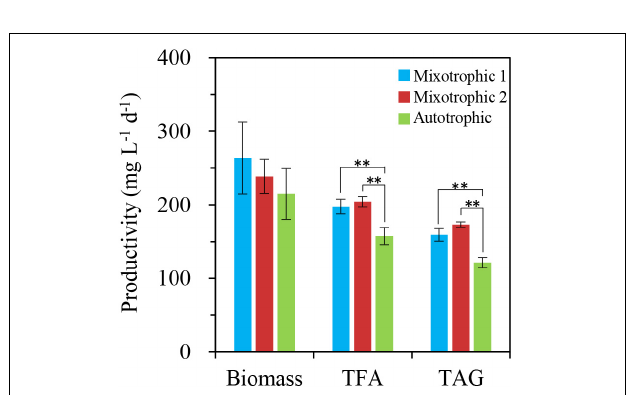
FIGURE 12 | Productivities of biomass, total fatty acids, and TAG in C. reinhardtii BAFJ5 under three carbon supply regimes over 48 h of HL-N. The carbon supply regimes for mixotrophic 1, mixotrophic 2, and autotrophic were 17 mM acetate and 2% CO 2 (v/v), 17 mM acetate and ambient 0.04% CO 2 (v/v), and 2% CO 2 (v/v), respectively. Values are the means of three independent replicates ± SD ( n = 3). TFAs, total fatty acids. ∗∗ p <